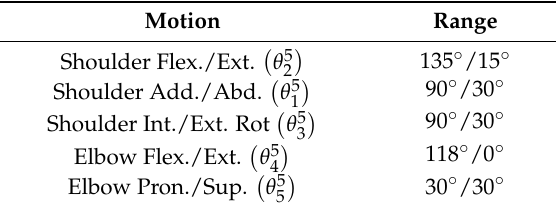
Table 2. Motion range of 5-DOF upper-limb exoskeleton.